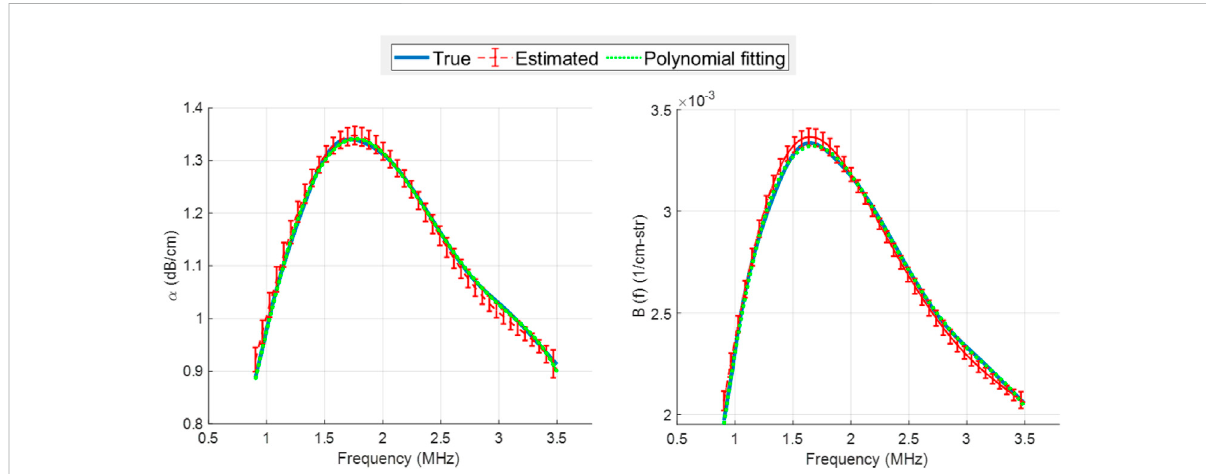
FIGURE 3 Attenuation, α (left)andbackscatter, B (right)spectra forSonoVuewith κ s =5× 10 − 9 kg/s, χ =0.5 N/m, σ ( R 0 )=0.02 N/m, atan acousticpressure of 10 kPa. In each plot, the true curve (solid blue), LLS estimated curve (dashed red) and the tenth-order polynomial fi tting to the true curve (dotted green) are displayed. The estimated curve is the mean computed over the estimator ’ s results on 10 different datasets, with errorbars denoting the standard